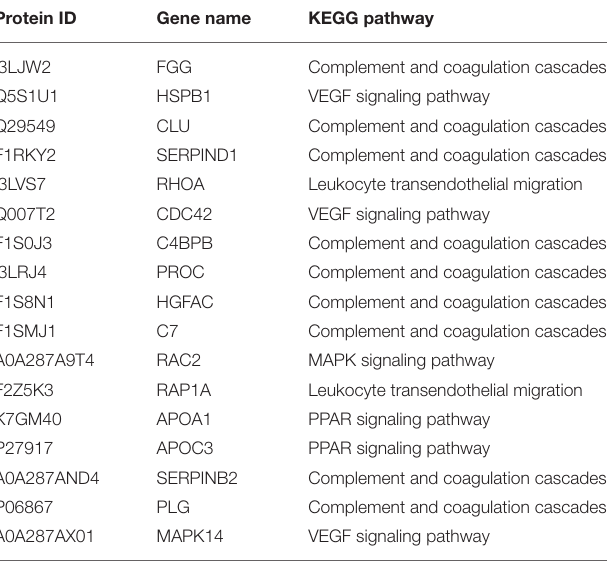
TABLE 2 | Information on Kyoto encyclopedia of genes and genomes pathway-related proteins in the vesicular fluid. Protein ID